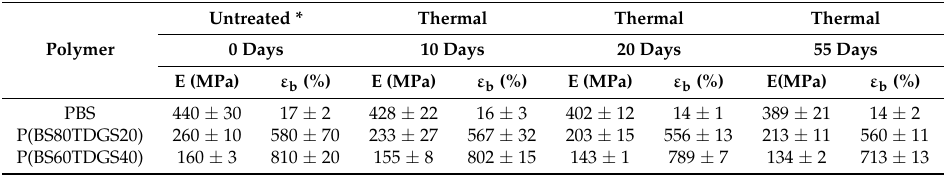
Table 7. Mechanical characterization data of PBS and P(BSxTDGSy) copolymers after thermal aging in the range 0–55 days.